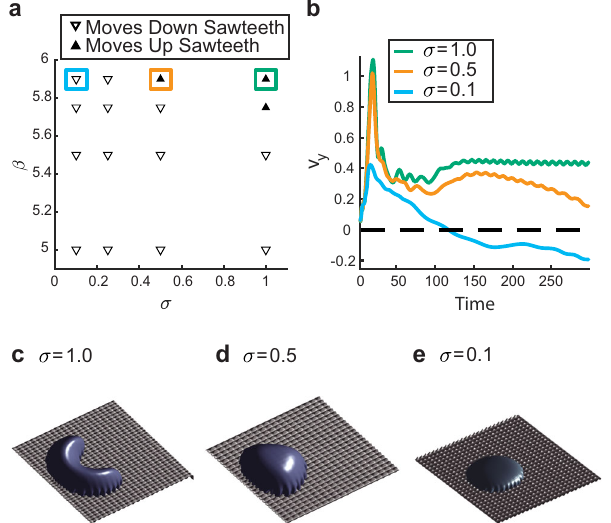
Fig. 3 The model parameters can be used to control shape and guidance independently. a A phase diagram showing the guidance direction as a function of the contractility σ and the actin polymerization rate β ( θ = 0.1) with initial polarization up the sawteeth. Increasing the contractility leads to a reversal in the guidance direction. b Cell migration behavior for different values of β and σ . For σ = 1, the cell's initial velocity decays rapidly to a more stable fi nal velocity. For σ = 0.5, the cell's initial velocity decay mirrors that for σ = 1, before decaying further at longer times. For σ = 0.1, the cell reverses direction at t ≈ 100 to move down the sawteeth. 3D visualizations of the stable cell-shape phenotype for ( c ) σ = 1, ( d ) σ = 0.5, and ( e ) σ = 0.1. As the contractility σ decreases, the cell becomes more oval shaped.